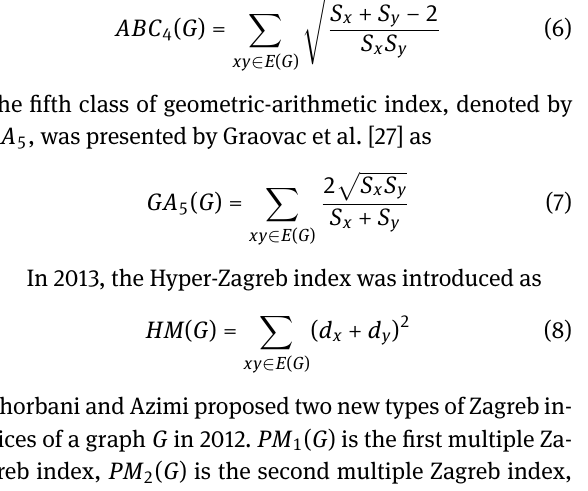
Figure 1: (a)molecular structure of Ethane, (b) molecular graph of Ethane, (c) Para-line graph of